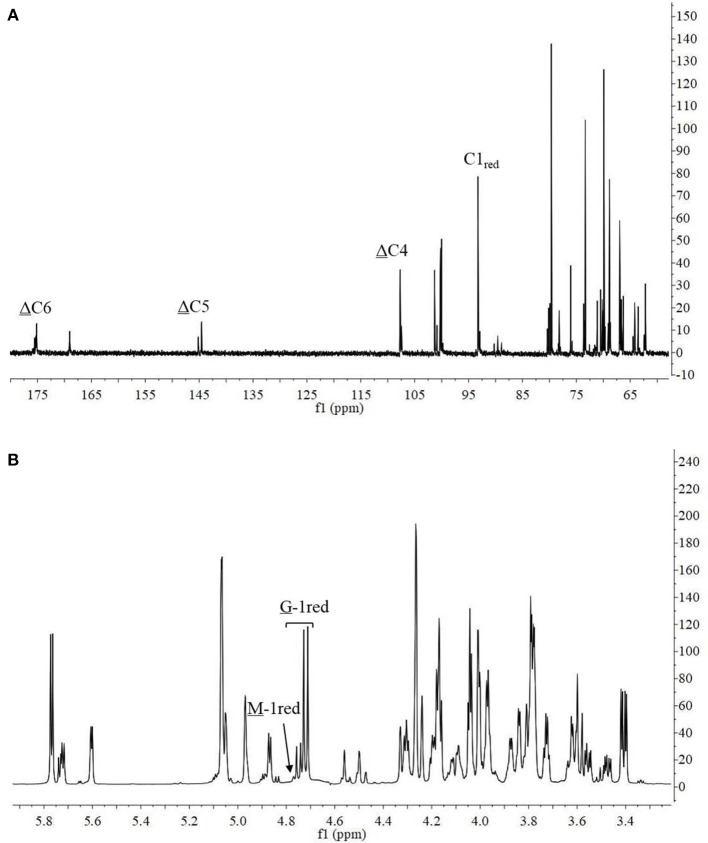
13C-NMR (A) and 1H-NMR (B) of AlyM hydrolysis products.